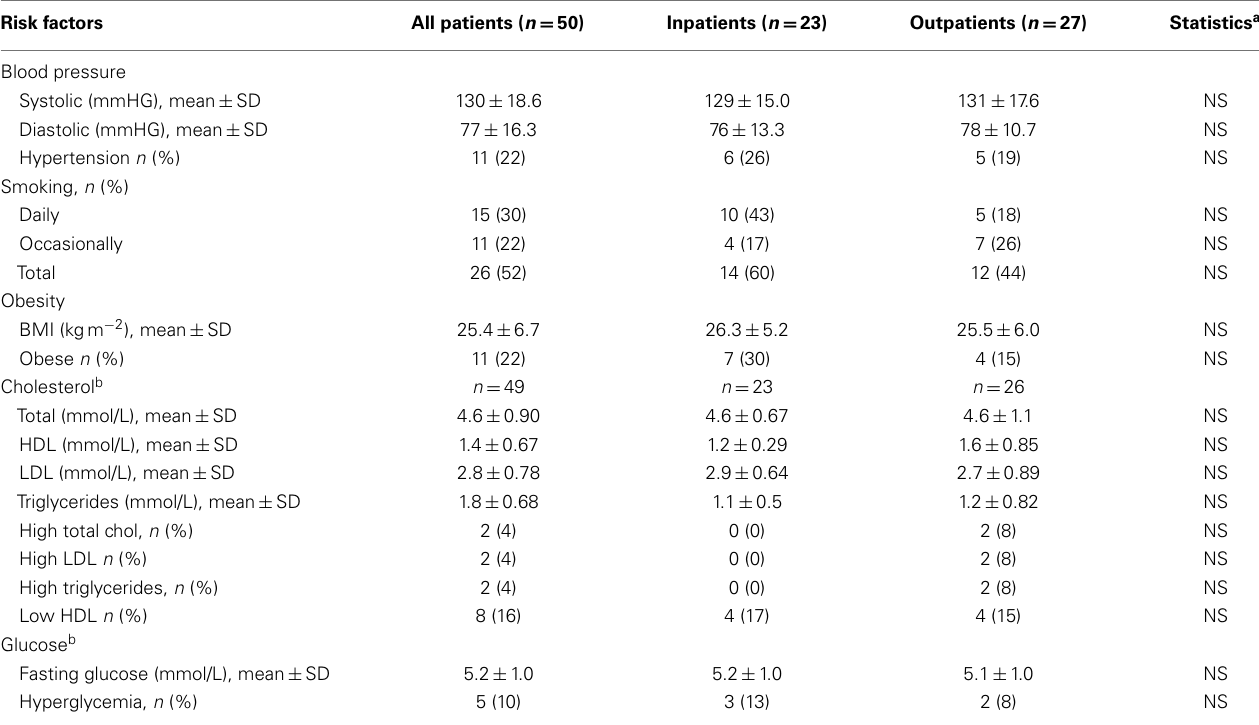
Table 3 | Frequency of traditional risk factors for CVD in 50 patients with severe mental disorders .